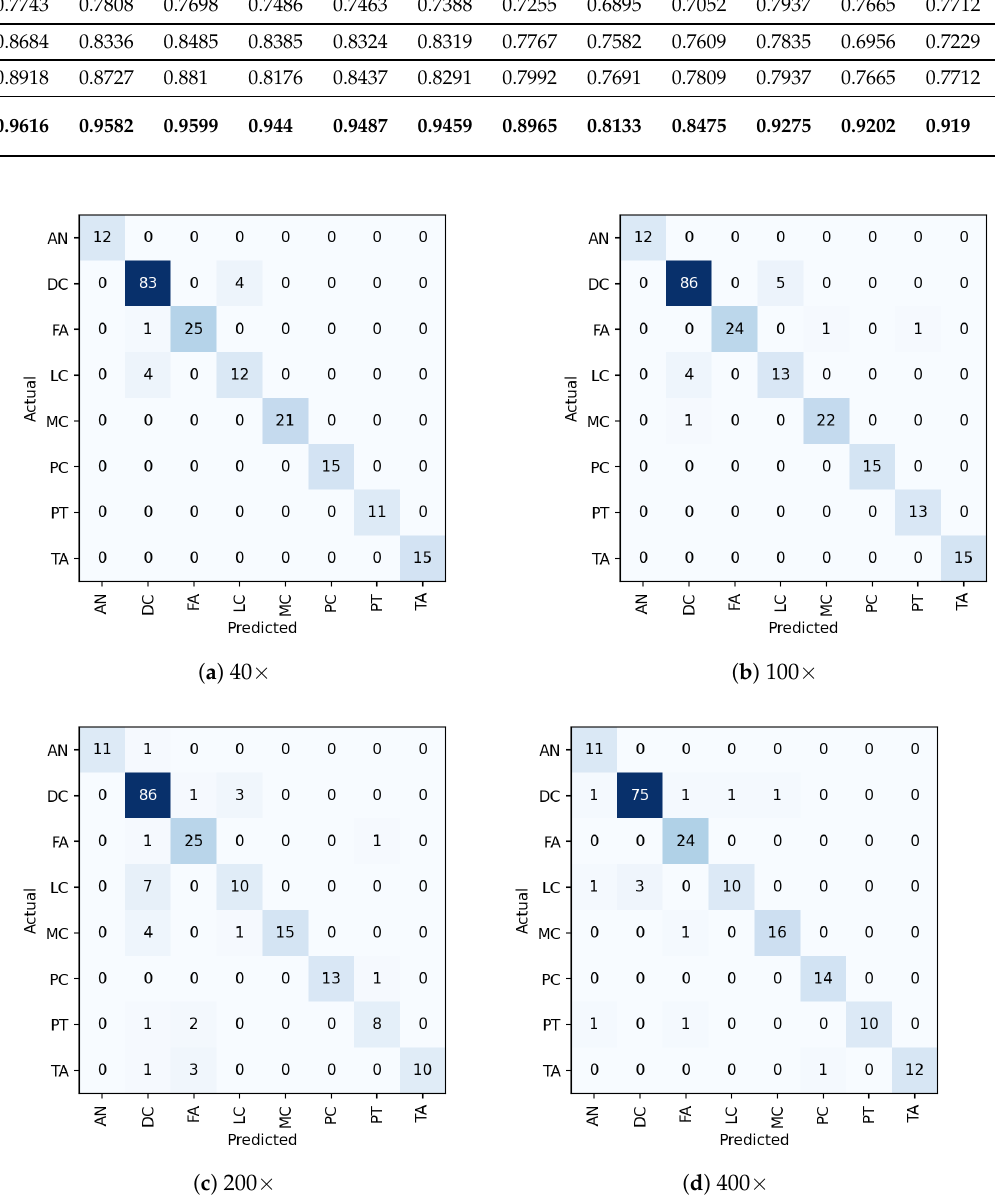
Figure 7. Illustration of multi-class confusion matrix obtained through the proposed model on the test set. Note that ( a – d ) refer to the 40 × , 100 × , 200 × , and 400 × magnifications,